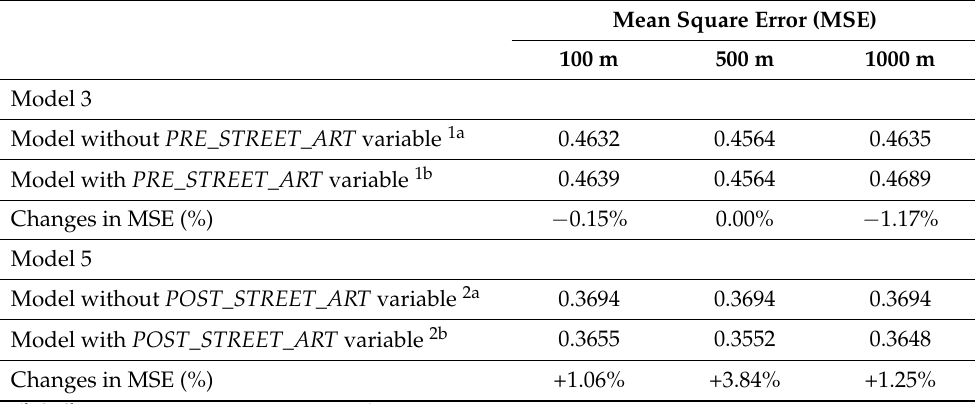
Table 11. Cross Validation for the Models of Price Premium of Street